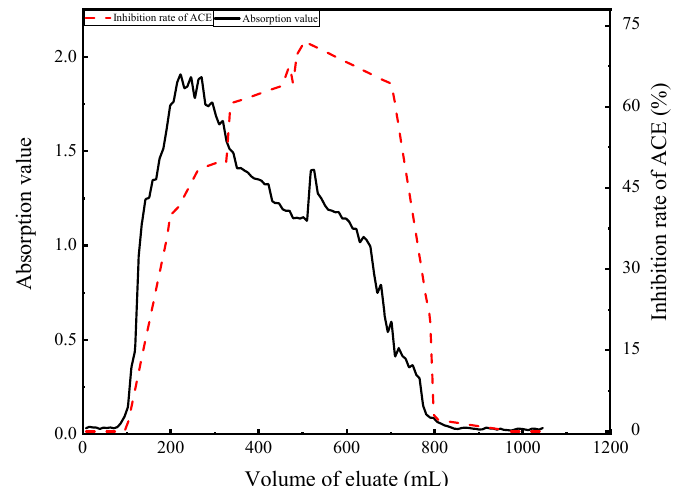
Figure 9. Dynamic adsorption curves of hydrolysates.